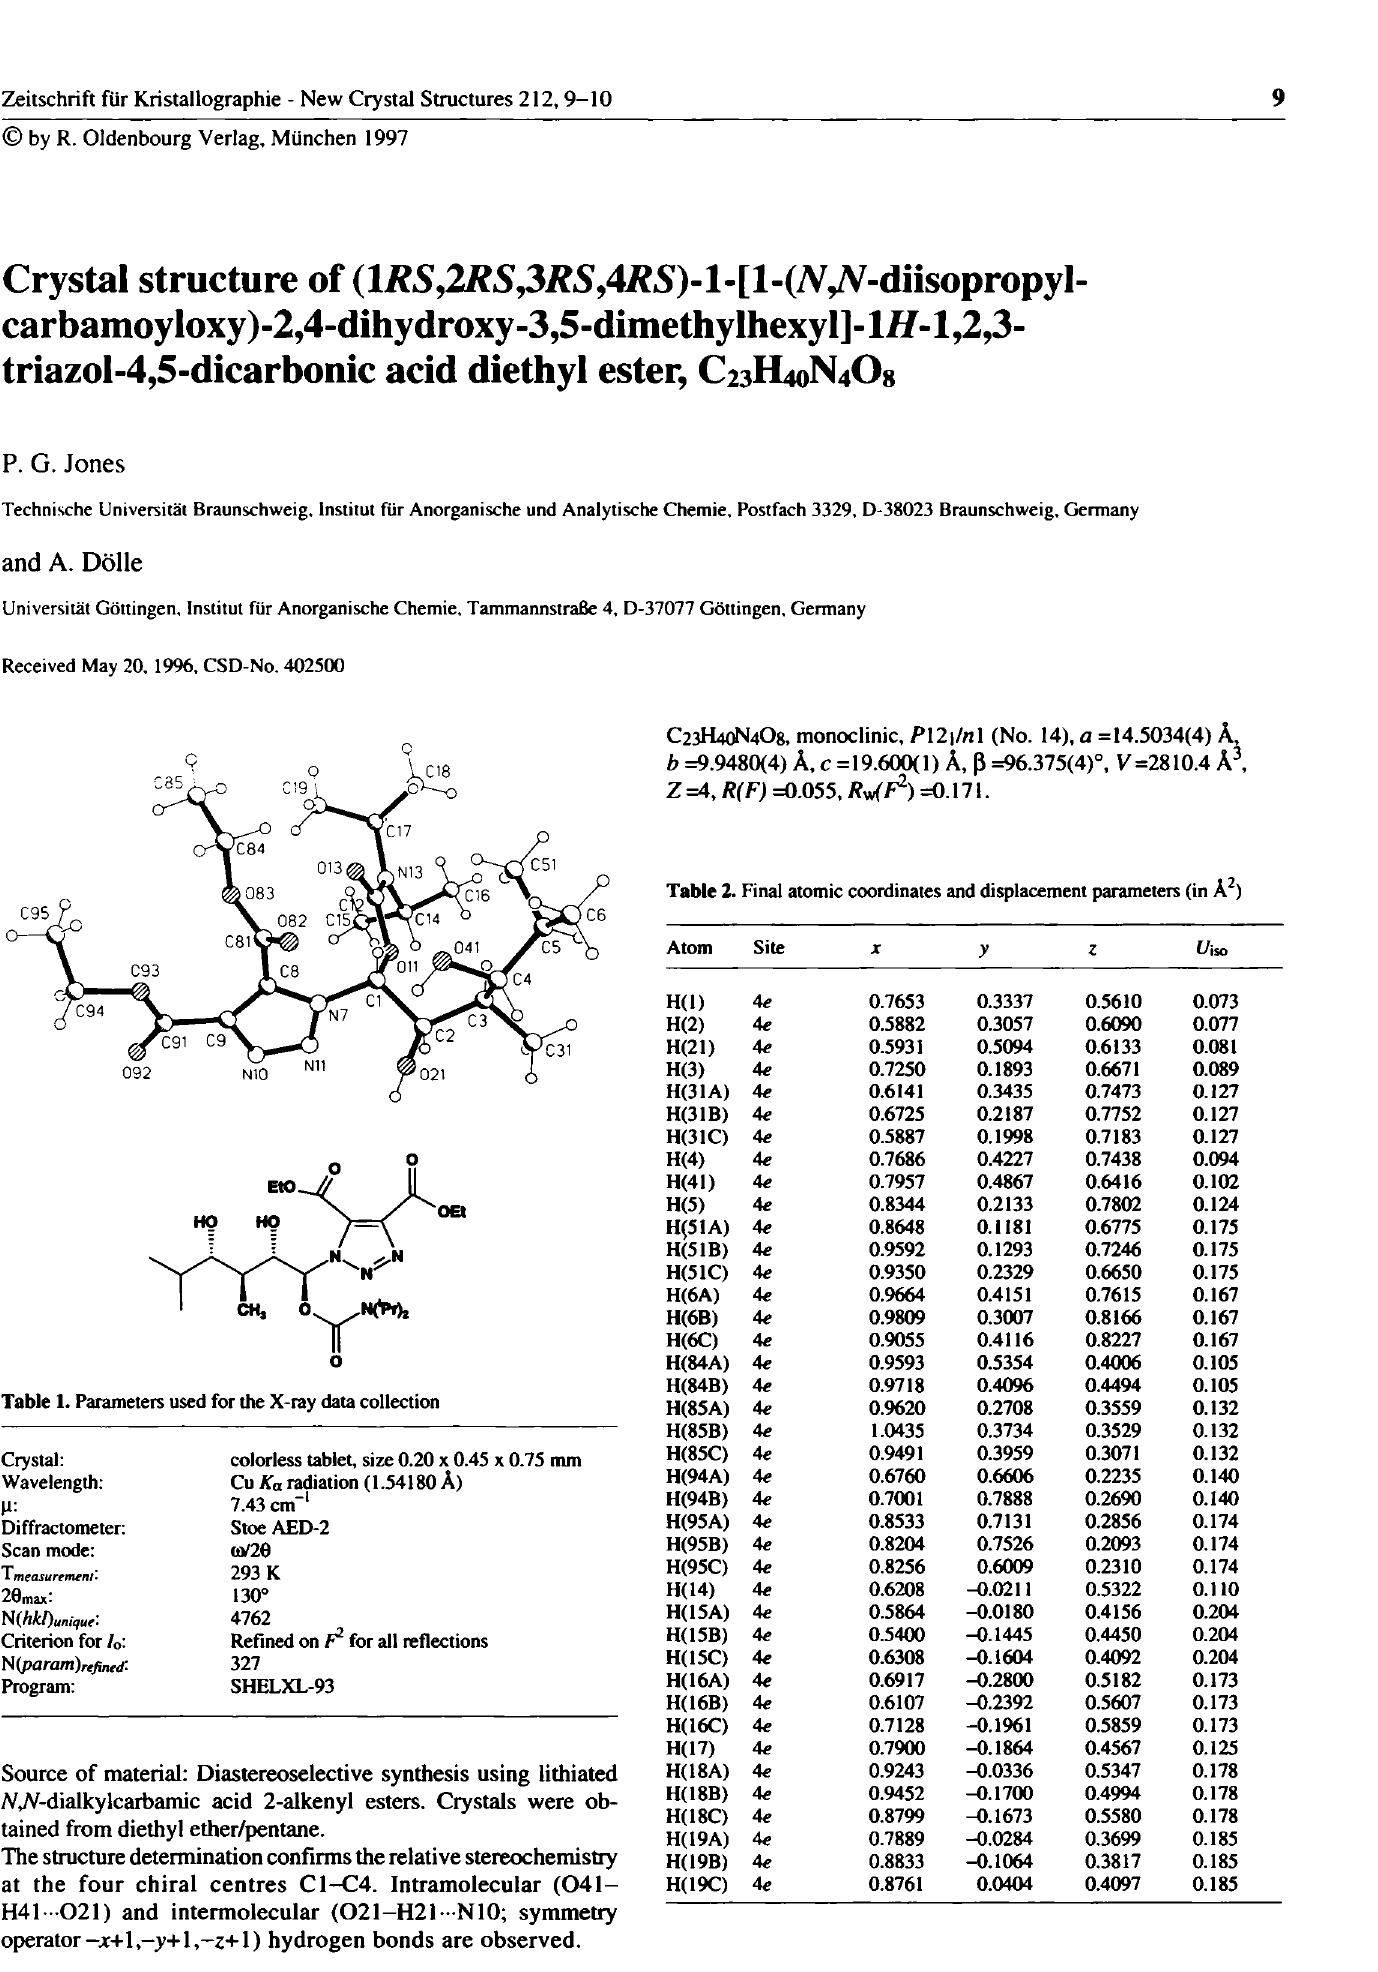
Table 1. Parameters used for the X-ray data collection